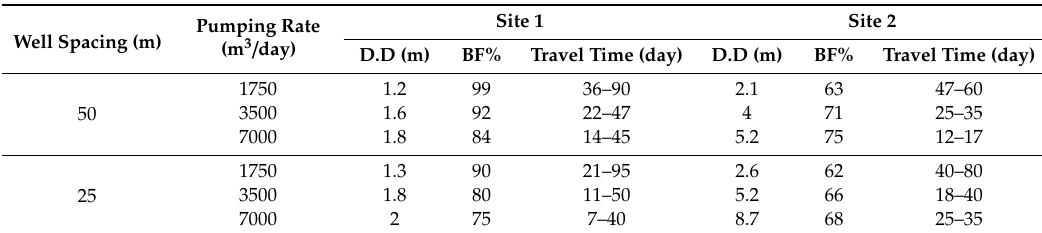
Table 2. E ff ect of well spacing on BF performance modelled parameters (i.e., bank-filtrate share BF%, drawdown D.D., and travel time) for wells operating at di ff erent pumping rates (m 3 /